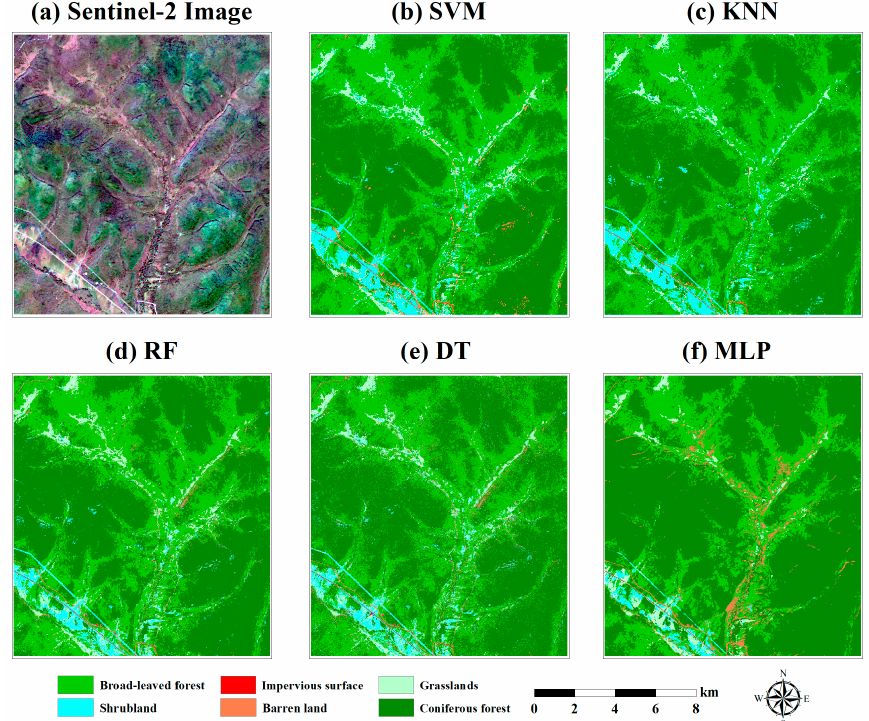
Figure 3. Sentinel-2 remote sensing image ( a ) and forest land resource information maps of the five-classifiers based on Mul features: ( b ) SVM classifier; ( c ) KNN classifier; ( d ) RF classifier; ( e ) DT classifier; ( f ) and MLP classifier.